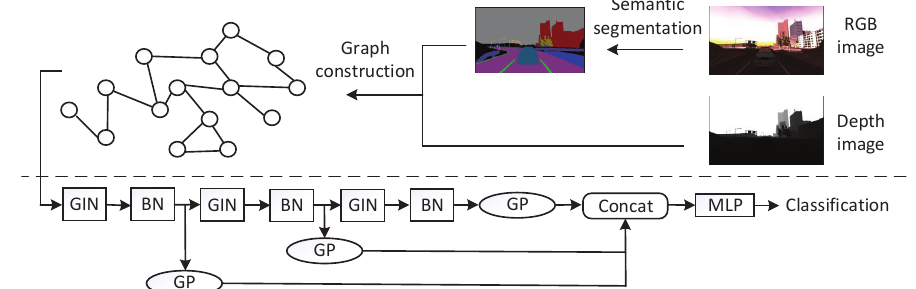
Figure 2. The architecture of our Visual Place Recognition (VPR) pipeline. The top half is the process of graph construction. The bottom half is our network architecture. We consider the Graph Isomorphism Network (GIN), Batch Normalization (BN), and Global Pooling (GP) layer as a unit which is piled up three times. The three outputs are concatenated as the graph global embedding.